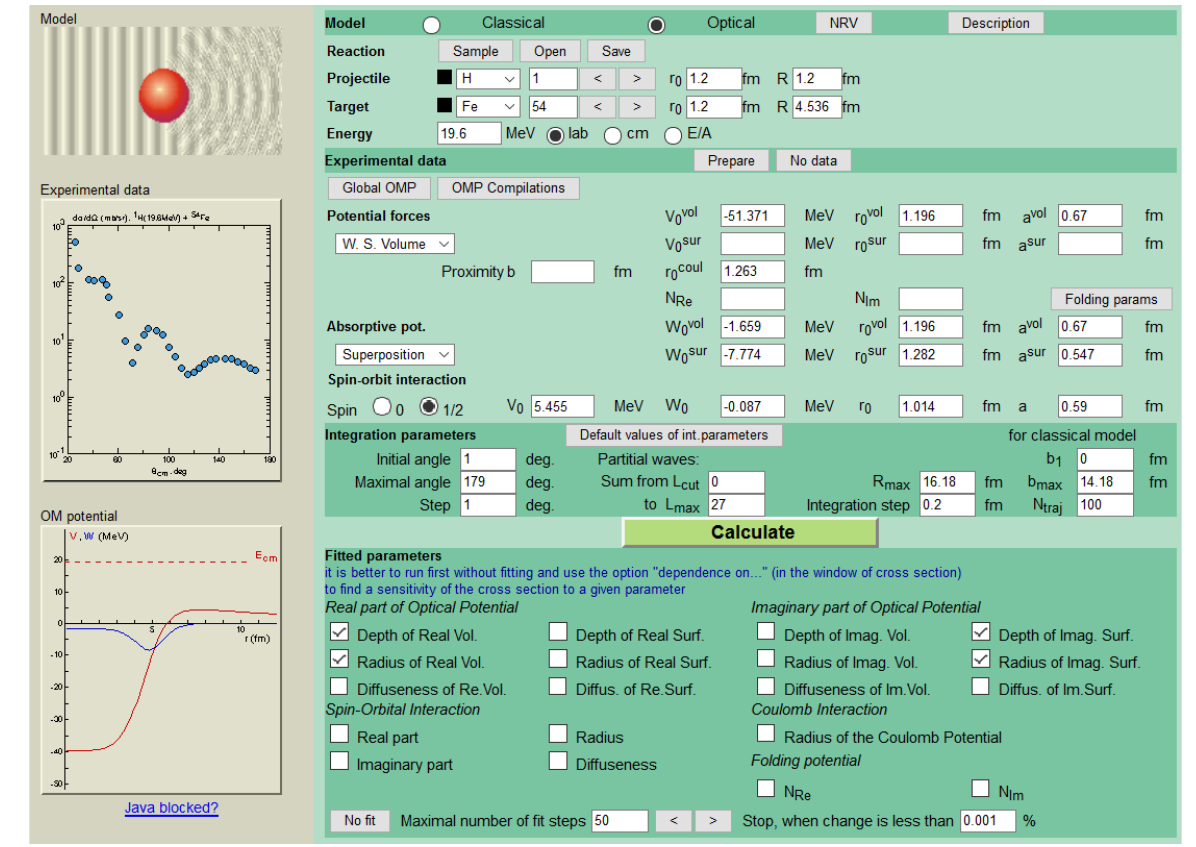
Figure 2. Screenshot of the NRV web page providing means for preparation of the Optical Model input